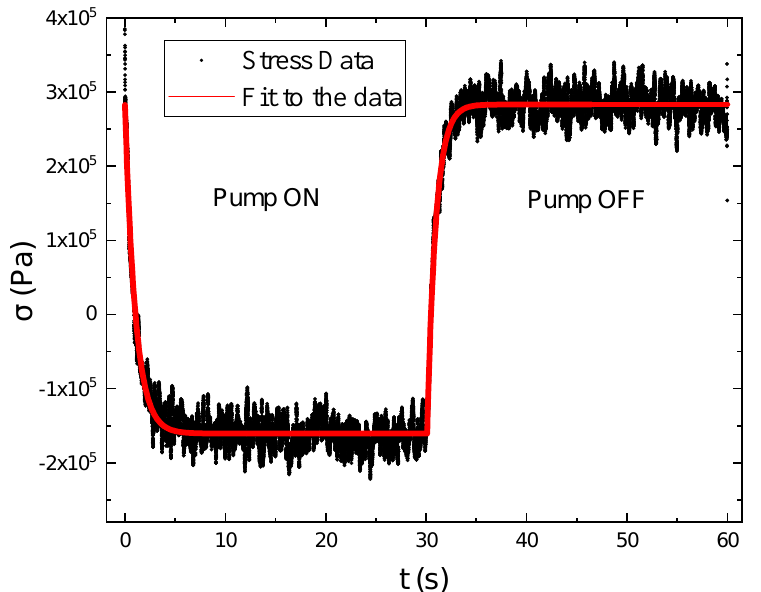
Figure 10. Typical time-dependent stress data (each point in the plot is smoothed over 100 points) and a fit to the theory given by Equations (33) and (34) (smooth curve) for a pump that turns on and off over a period of 60